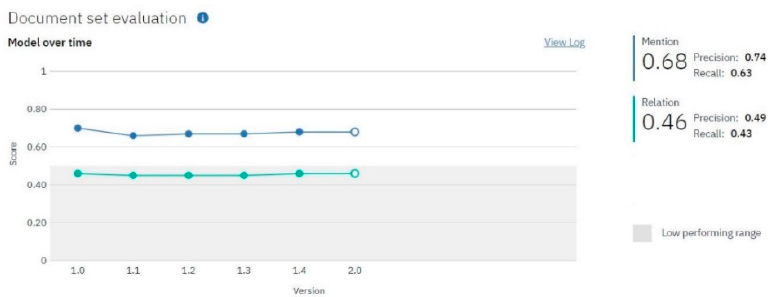
Figure 6. The evolution of the NER model and the obtained values for indicators according to Knowledge Studio.